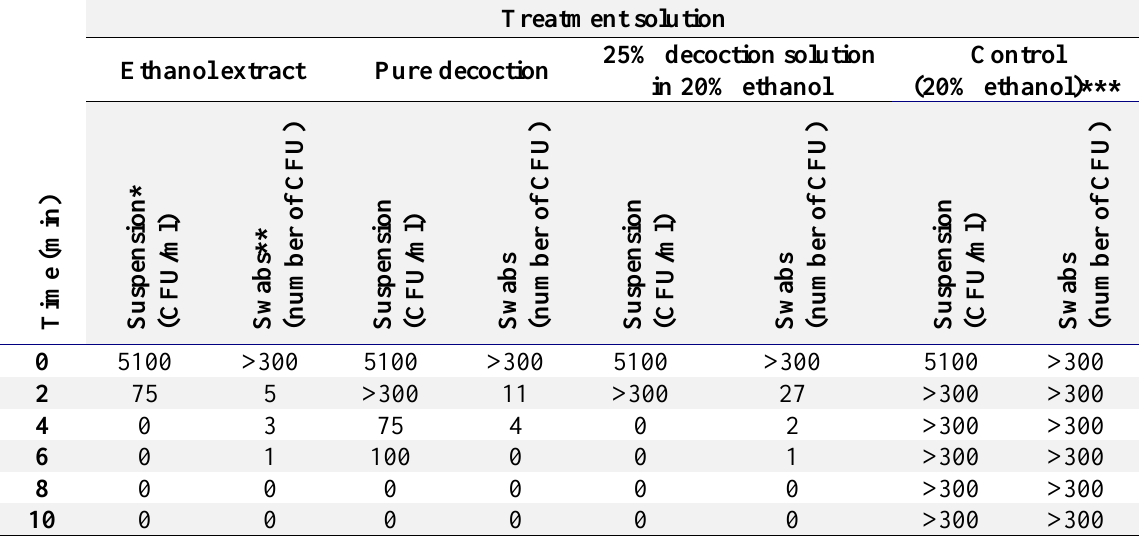
Table 5. Effect of submersion in different Allium cepa treatment solutions on Salmonella cell count on